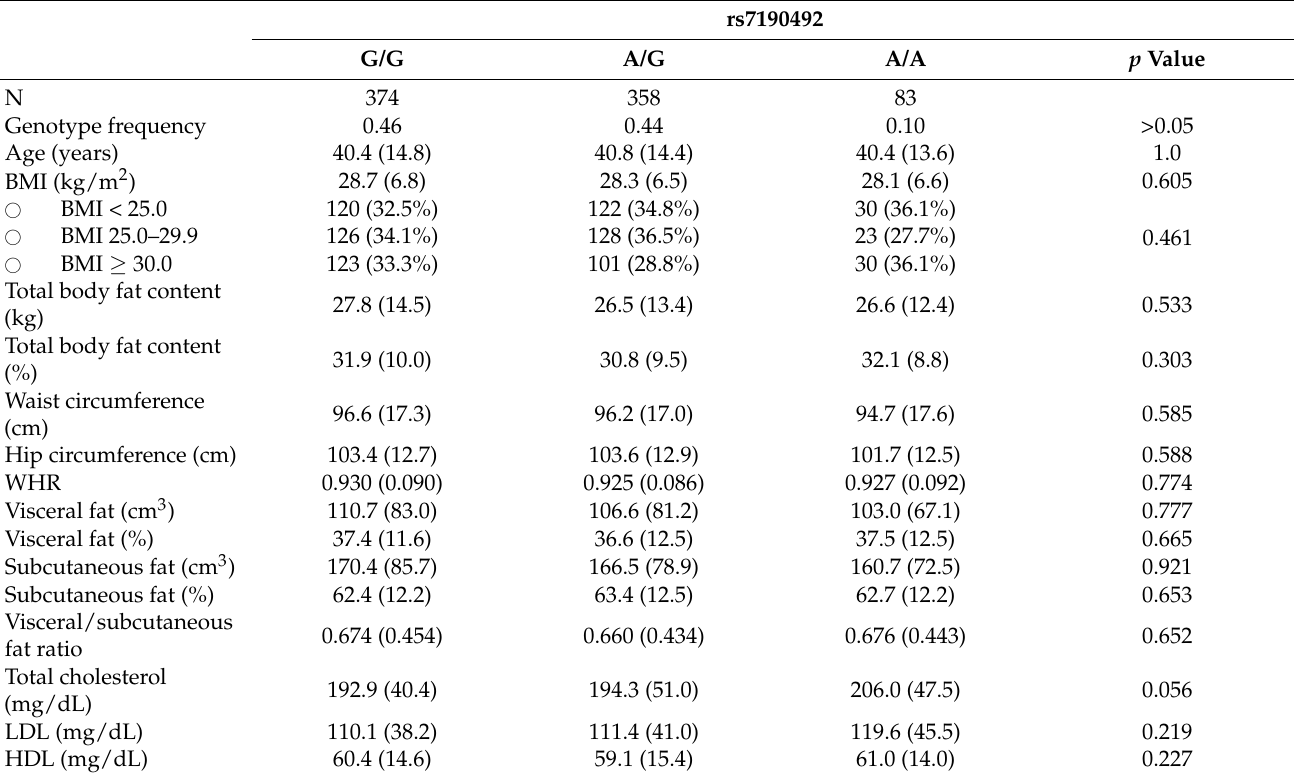
Table 3. Characteristics of participants stratified by rs7190492